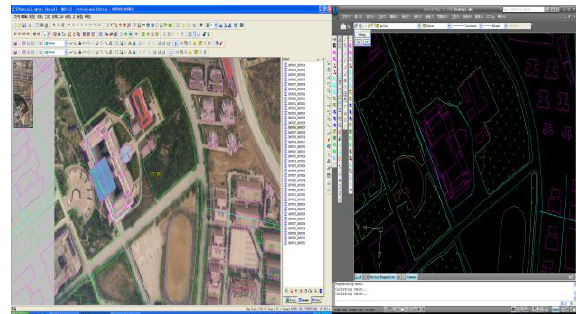
Figure 2. MAP-LCS stereo mapping for 3d vector data